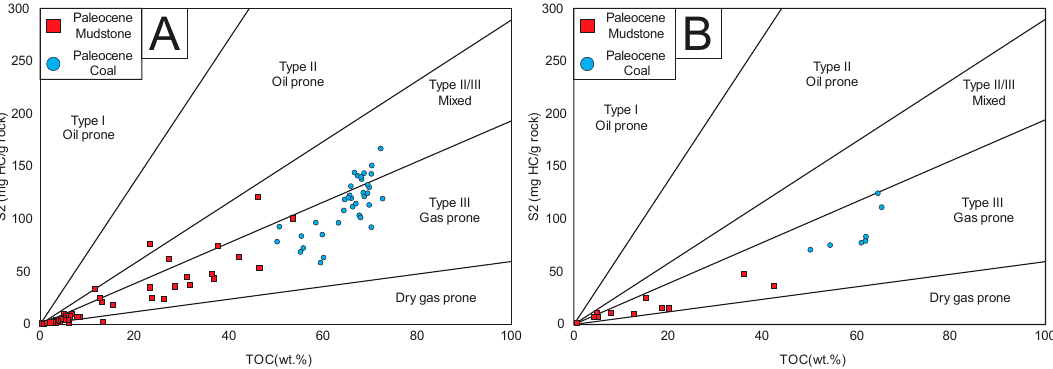
Figure 11. Cross plot of S2 versus total organic carbon (TOC) to exhibit the generating potential of the Cerrej ó n Formation in the ( A ) ANH-CARRETALITO-1 and ( B ) ANH-CAÑABOBA-1